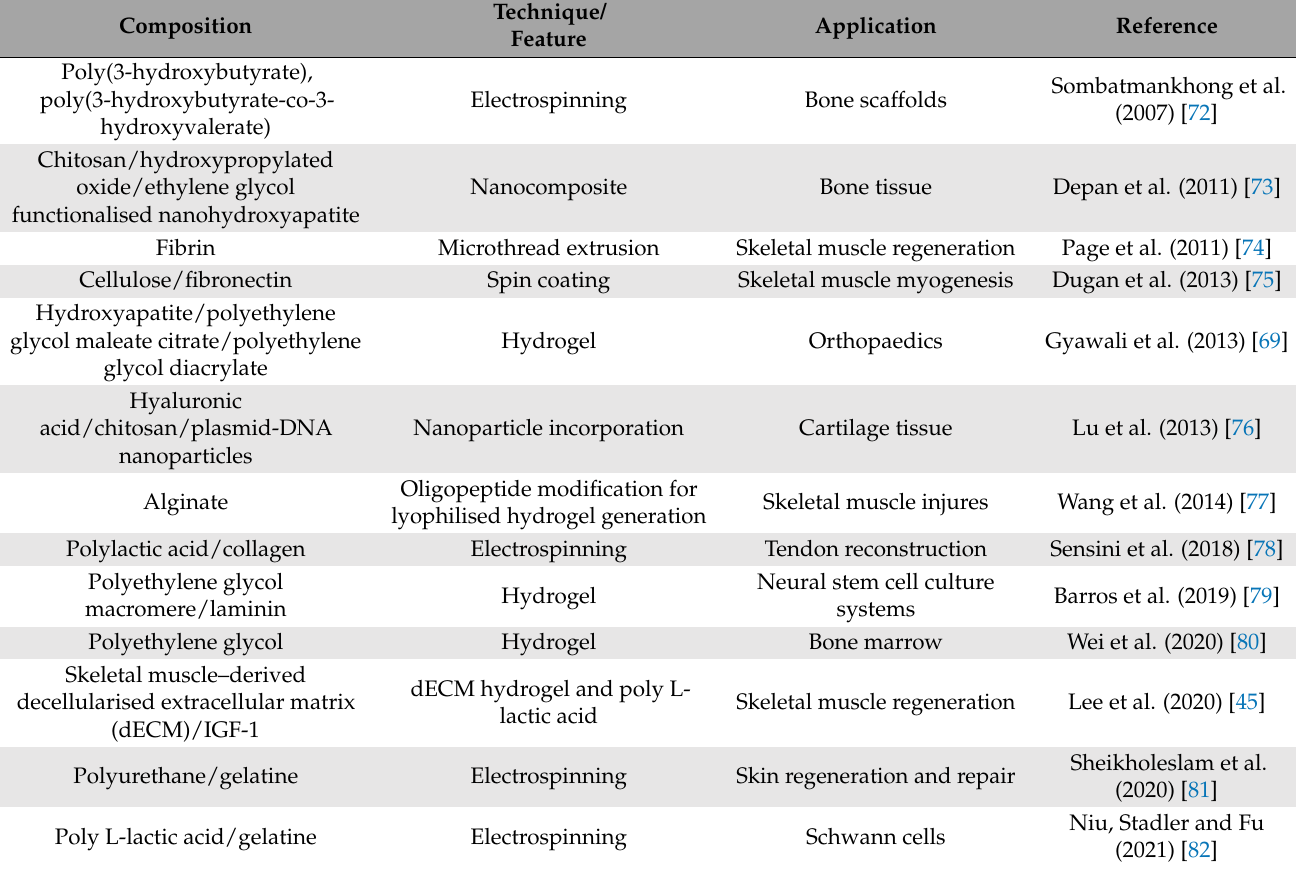
Table 3. Chemical compositions and techniques used to construct